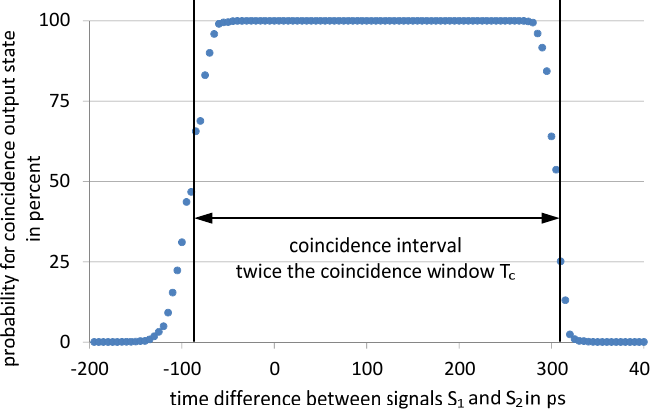
Figure 8. Timing behavior of the proof-of-concept implementation of a